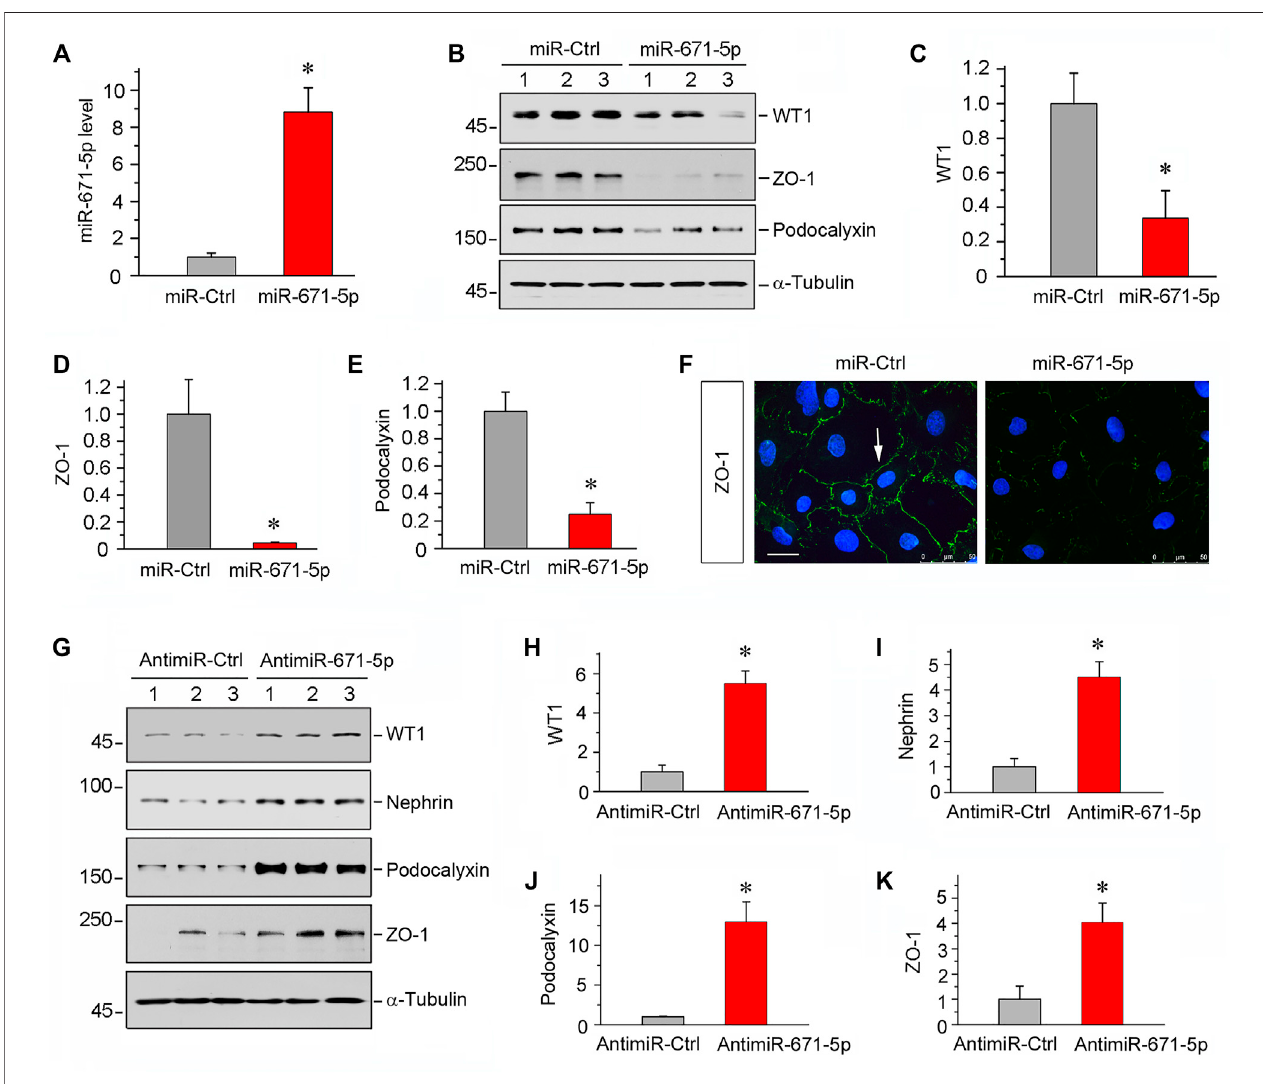
FIGURE2| OverexpressionofmiR-671-5pimpairsbutknockdownofmiR-671-5pprotectspodocyteintegrity invitro .Mousepodocytes(MPC5)weretransfected withmiR-671-5p mimics (miR-671-5p)or negative control(miR-Ctrl) for24 h. (A) qRT-PCR analysisshows therelativelevels ofmiR-671-5p after transfection. * p < 0.05 ( n (cid:1) 3). (B – E) RepresentativeWesternblot (B) andgraphicpresentationsofWT1 (C) ,ZO-1 (D) andpodocalyxin (E) werepresented.* p < 0.05( n (cid:1) 3). (F) Representative micrographs show the expression and distribution of ZO-1 in podocytes after miR-671-5p overexpression. Scale bar, 50 µm. (G – K) Inhibition of miR-671-5p protects podocyte integrity. MPC5 cells were transfected with miR-671-5p inhibitor (AntimiR-671-5p) or control (AntimiR-Ctrl) or for 24 h. Representative Western blot (G) and graphic presentations of WT1 (H) , nephrin (I) , podocalyxin (J) and ZO-1 (K) were presented. * p < 0.05 ( n (cid:1) 3).